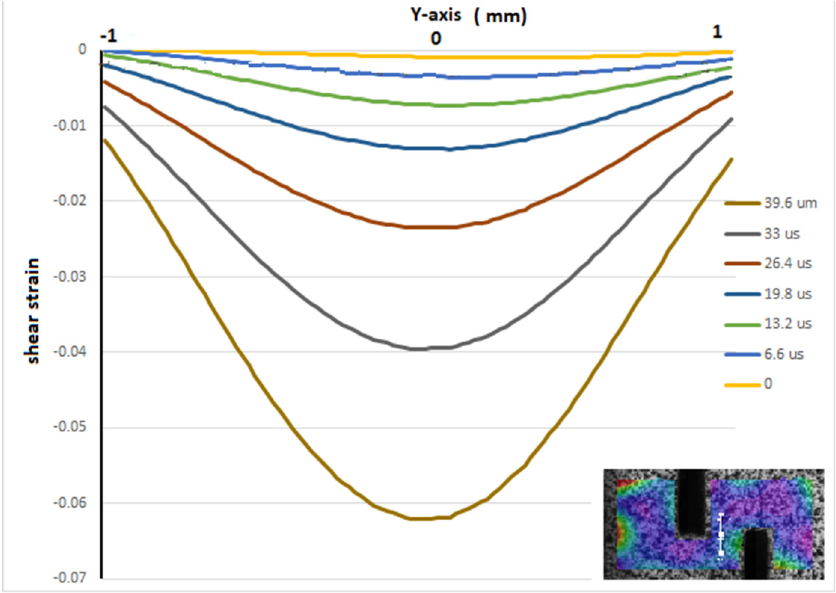
Figure 14. Distribution of shear stress on the Y-axis at different times.